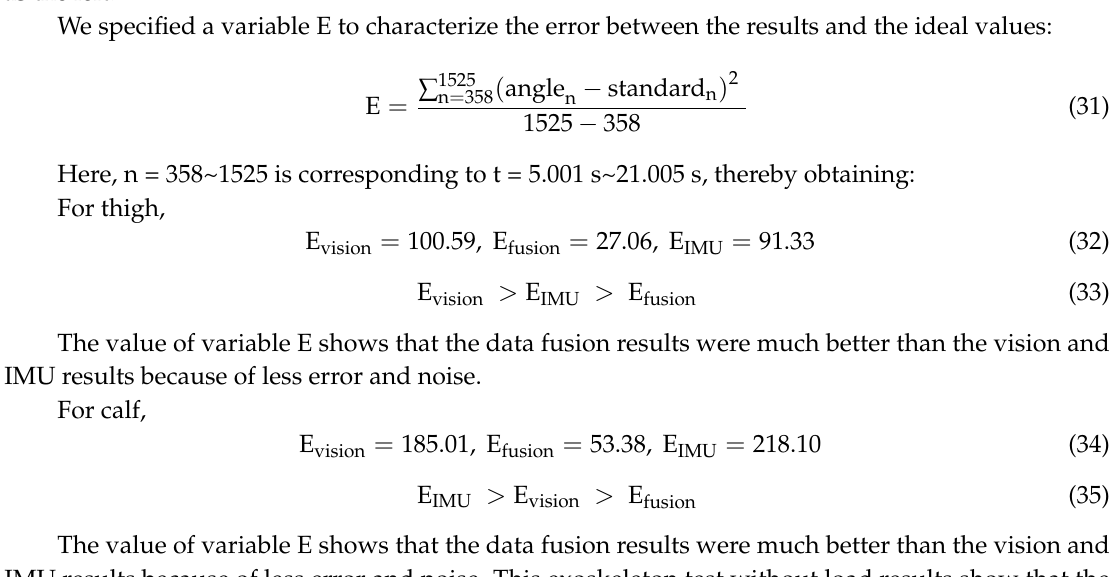
Figure 13. Exoskeleton without load ( a ) and human with exoskeleton ( b ). The whole human test with the exoskeleton is shown in Figure 14.